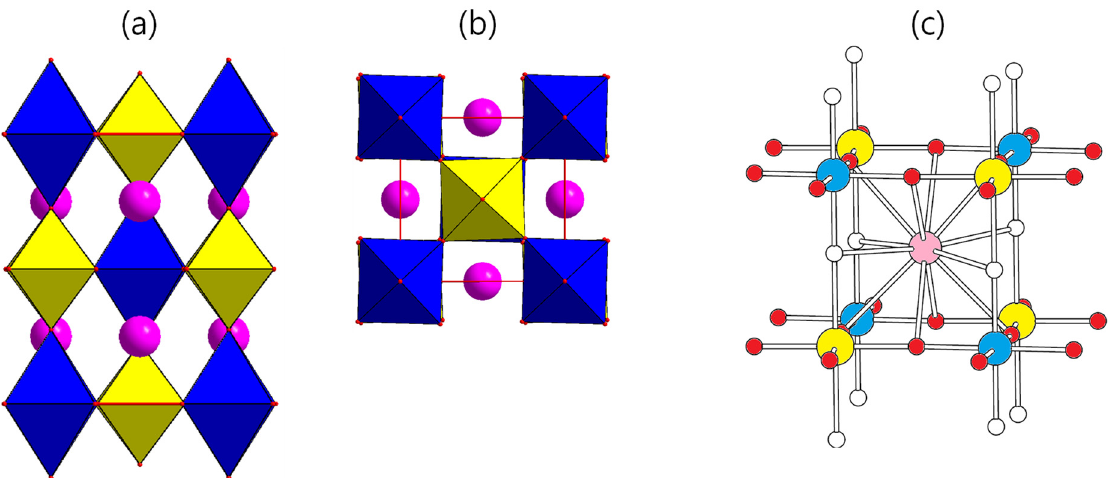
Figure 1. Crystal structure of Ba 2 CuOsO 6 , where blue polyhedra and yellow polyhedra and blue, yellow, pink, red, and white circles represent CuO 6 and OsO 6 units and Cu, Os, Ba, O eq , and O ax atoms, respectively. Perspective view of ( a ) ac plane and ( b ) ab plane. ( c ) Arrangement of the Ba-centered Cu 4 Os 4 cube in which the Ba ion is connected by 4 O ax and 8 O eq atoms.